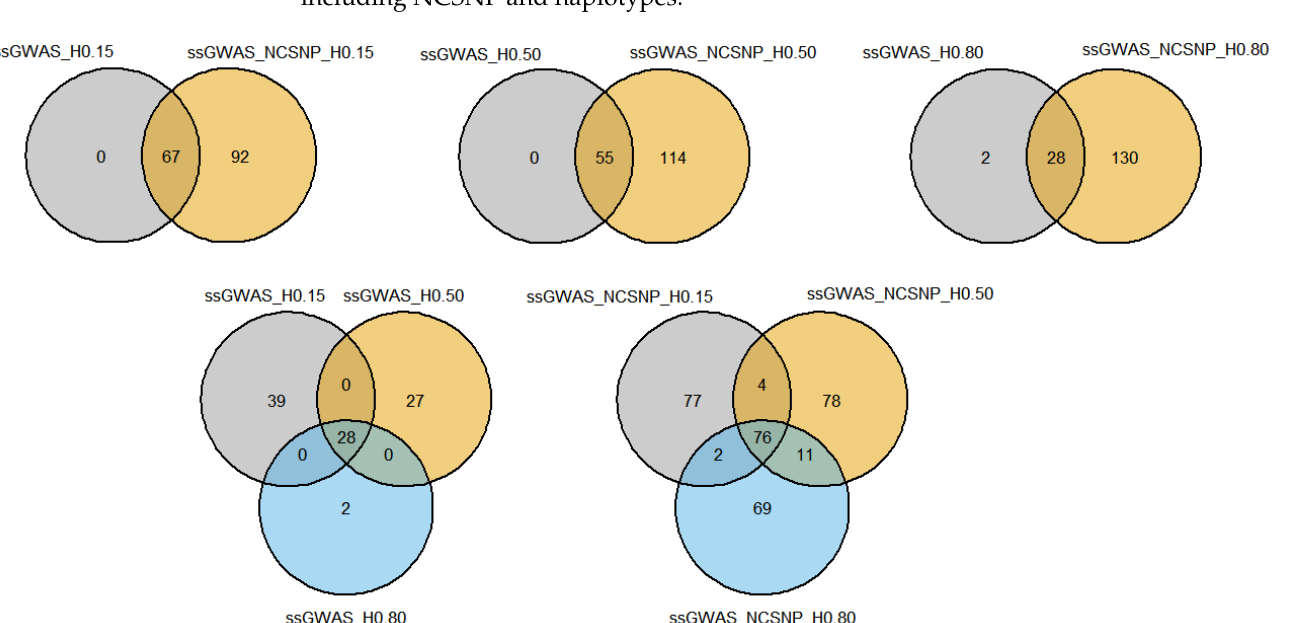
Figure 11. Absolute number of quantitative trait loci (QTL) by class overlapping with the top 0.001% markers for yearling temperament in American Angus cattle using the single-step GWAS fitting only haplotypes or non-clustered SNPs and haplotypes. ssGWAS_H0.15, ssGWAS_H0.50, and ssGWAS_H0.80: ssGWAS using only haplotypes from blocks with link- age